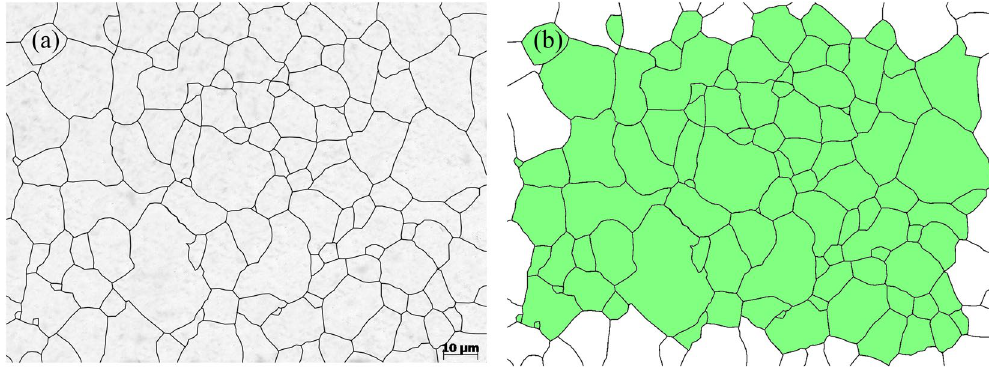
Figure 2. The grain size of the original austenite grain. ( a ) Metallographical image; ( b ) The area used to obtain the grain